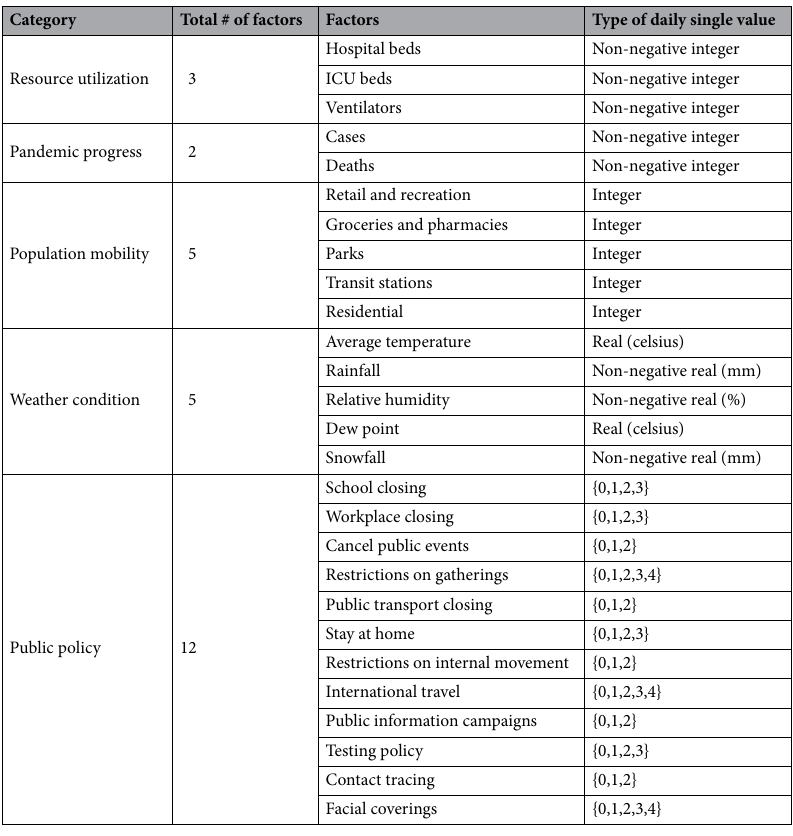
Table 2. The 27 factors, sorted into resource utilization, pandemic progress, population mobility, weather condition, and public policy. The numeric value for each factor, for each time and each region, is the average of the 7 daily values, associated with the 7th day.